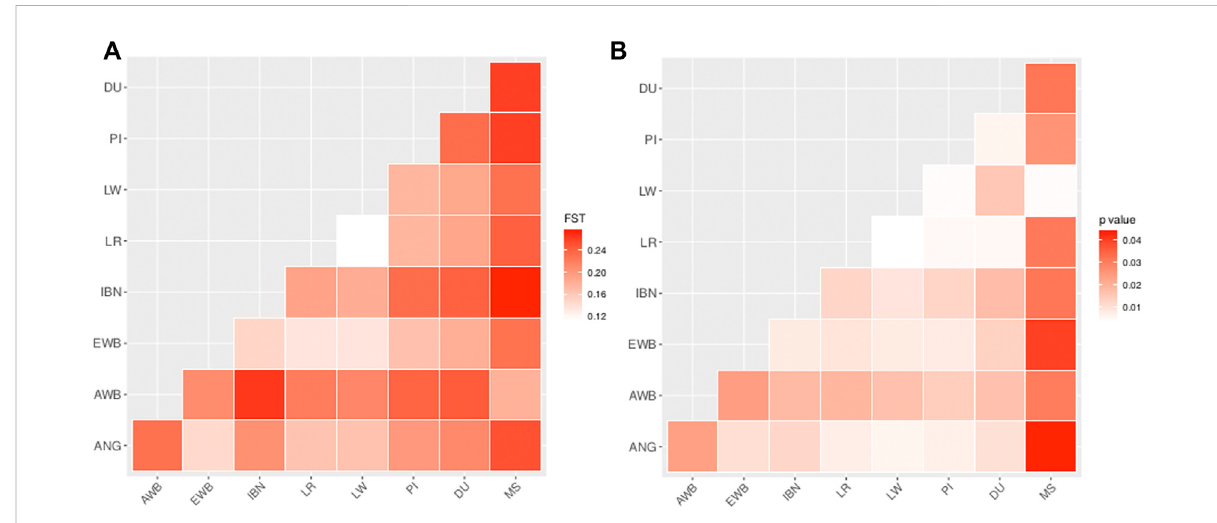
FIGURE 3 Pairwise F ST estimations in all studied pig populations. (A) Pairwise F ST between the Bailundo pigs (ANG) and the major domestic and wild populations of Eurasia. IBN — Iberian; LR — Landrace; LW — Large White; DU — Duroc; PI — Pietrain; EWB — European Wild Boar; MS — Meishan; AWB — Asian Wild Boar. (B) Pairwise F ST corresponding p -values with 100 bootstraps.